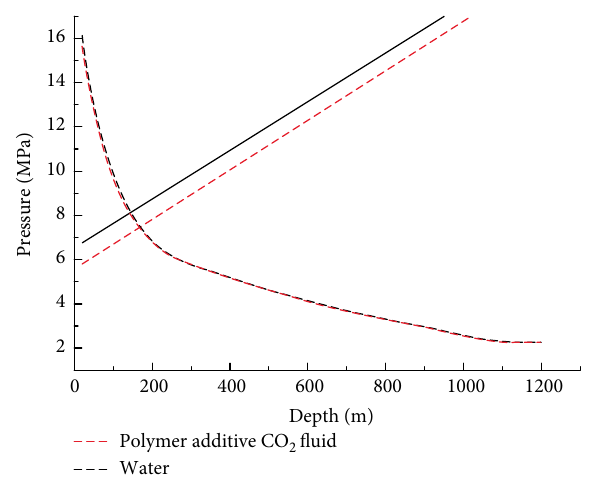
Figure 7: The annulus pressure distribution and hydrates phase equilibrium comparison between the polymer additive CO water as drilling